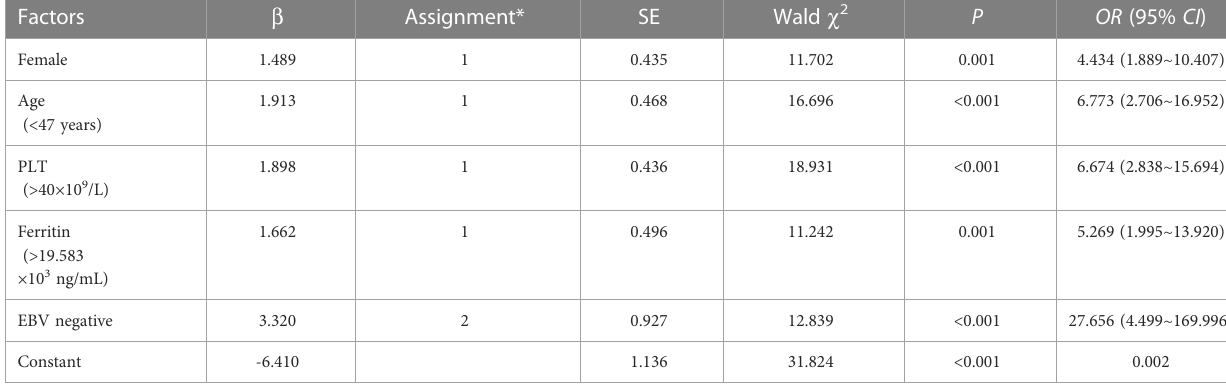
TABLE 5 Multivariate logistic analysis of independent risk factors associated with immune or haematologichematologic diseases. Factors